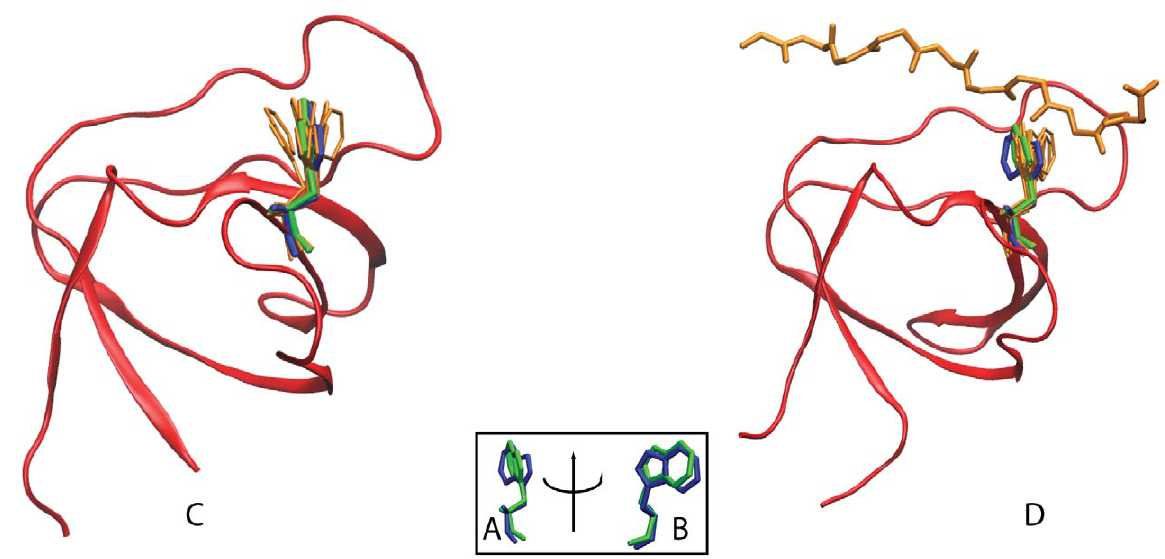
Figure 3. Flexibility of the conserved tryptophan switch in Grb2. (A) and (B) show the expected conformations of the W switch for class I (blue) and class II (green) peptide bound SH3 domains based on static x-ray structures (PDB IDs 1CKA and 1ABO respectively). In MD simulations of the C-SH3 of Grb2, the flexibility of the W switch is greater than the flexibility required to bind both class I and II peptides in the (C) apo and (D) peptide bound Grb2 simulations.